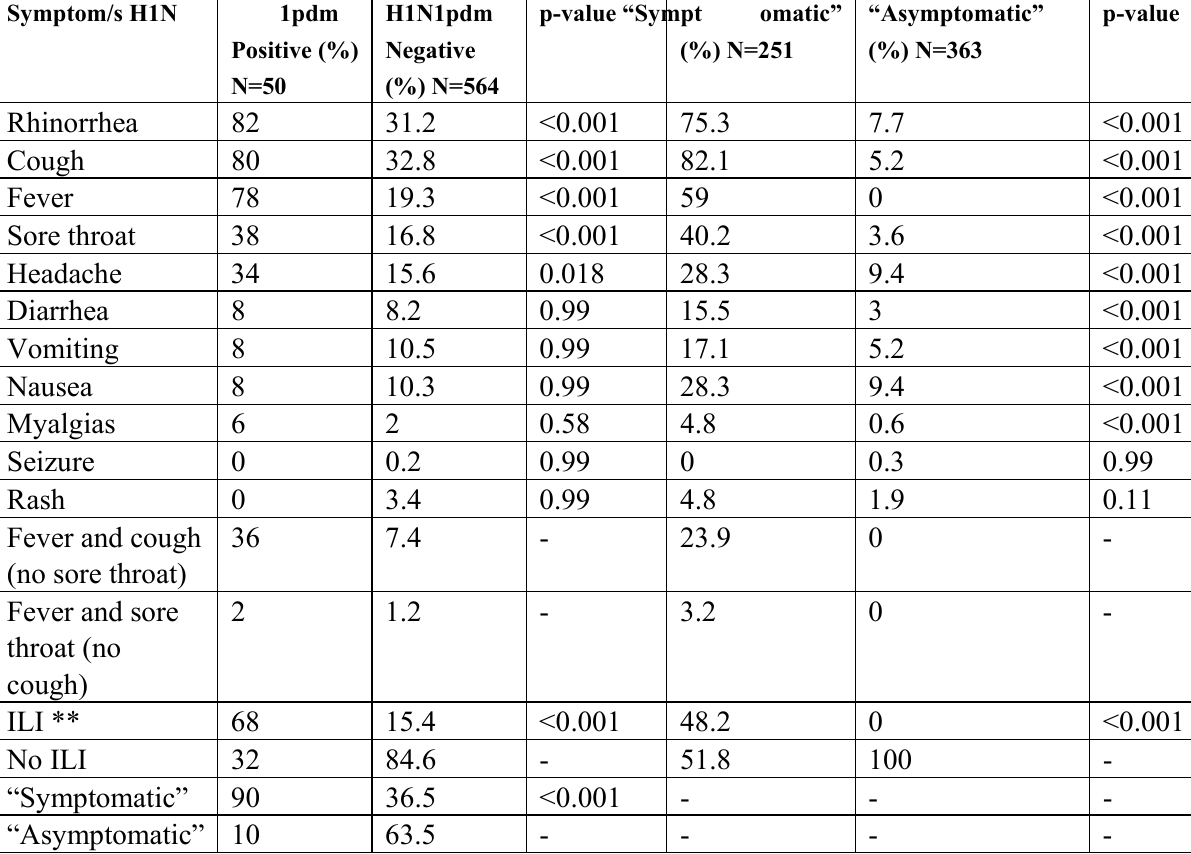
Table 1. Prevalence of Symptoms in H1N1pdm Infected and Uninfected Subjects and “Symptomatic” and “Asymptomatic” Subjects in Targeted